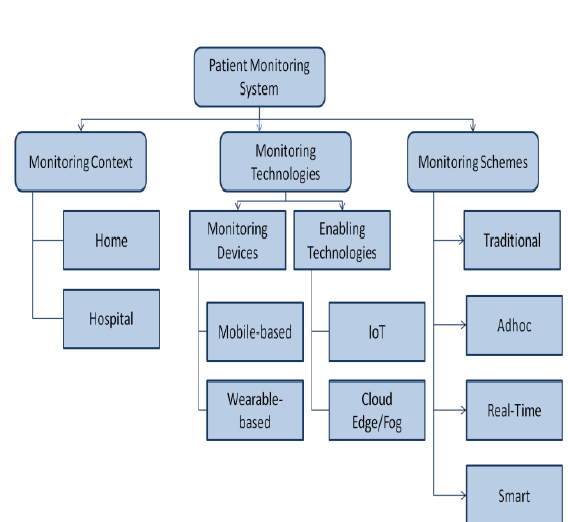
Figure 2. Clustering of Patient Monitoring System IoT describes the ance picture of